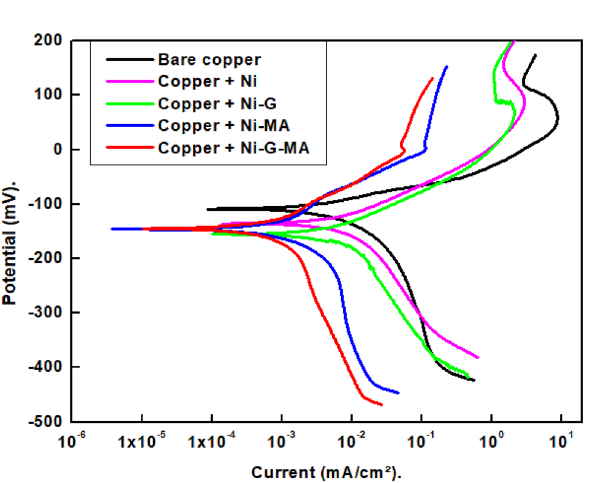
Figure 8. Potentiodynamic polarization curves for bare and coated copper with Ni, Ni-G, Ni-MA, and Ni-G-MA in 0.5 M NaCl